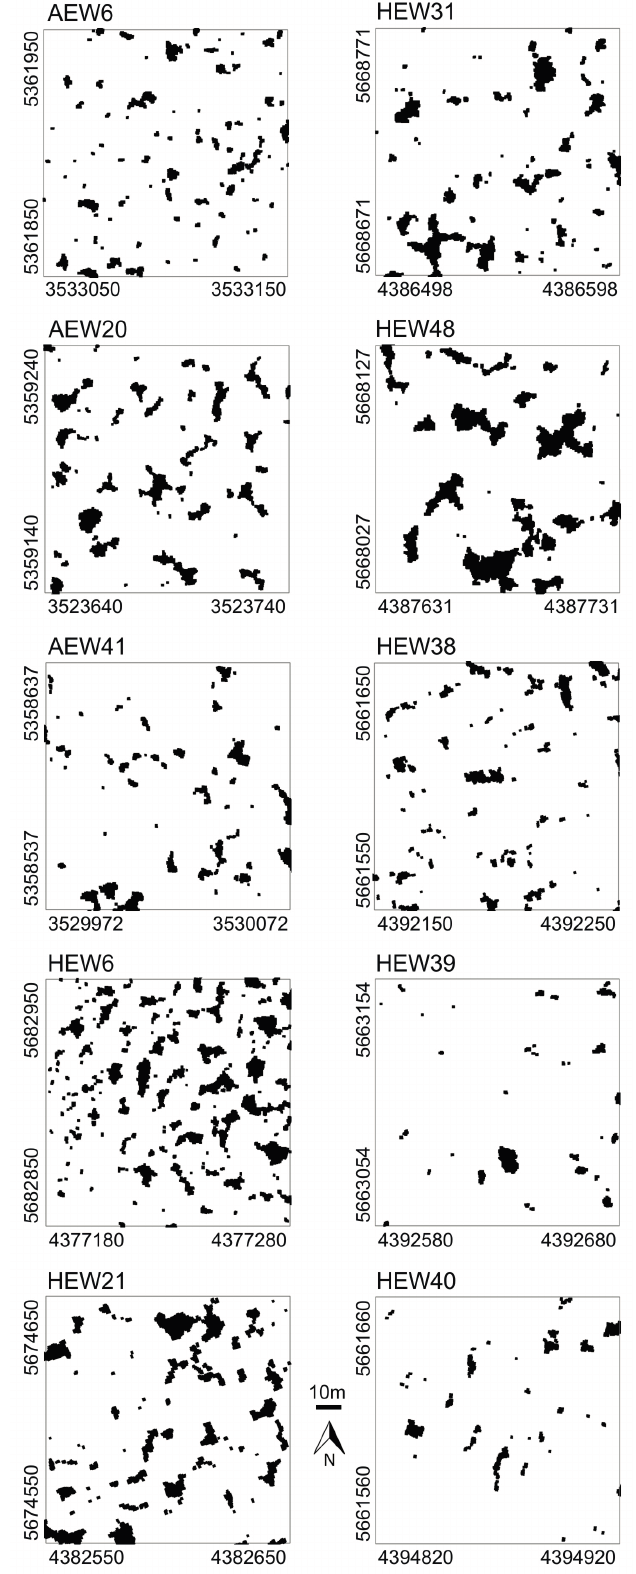
Figure 2. Delineated gap patterns of the 1-ha study plots. ( Left ) Age-class forest. ( Right ) Selection-cutting forest (upper two) and unmanaged forest (lower three). The Gauss–Krüger coordinates are given in meters and depict the corners of the 100 m × 100-m study